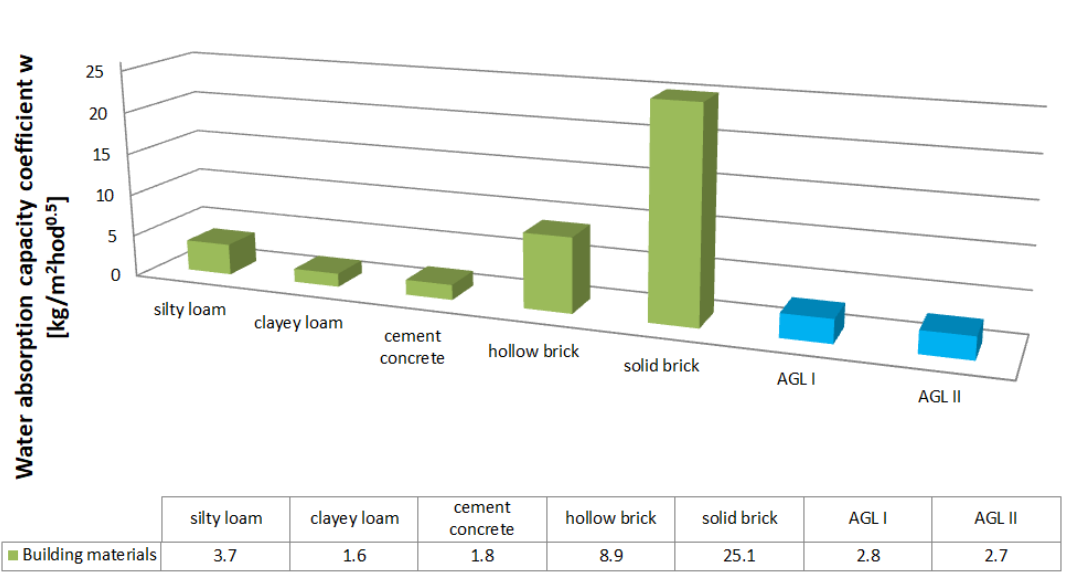
Figure 5. Water absorption capacity coefficient of common building materials and tested rammed earth